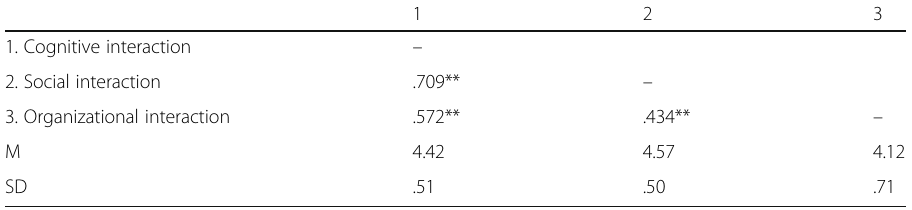
Table 6 Spearman correlation matrix for the three types of interactions identified in CSCL 1 2 3 1. Cognitive